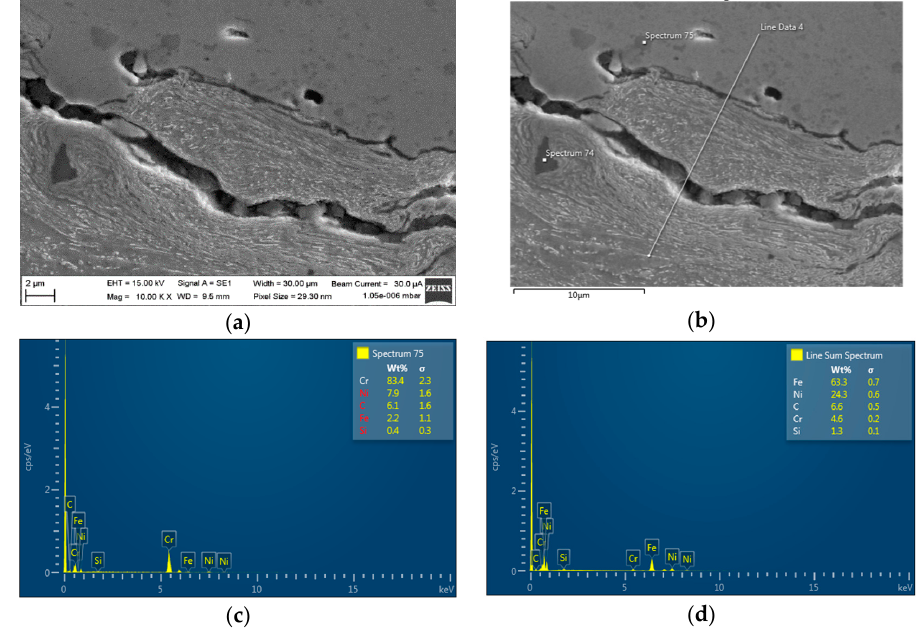
Figure 1. Morphology of NiCrBSi powder: ( a , b ) NiCrBSi powder spraying obtained by scanning electron microscopy; ( c , d ) EDX analysis of NiCrBSi powder. electron microscopy; ( c , d ) EDX analysis of NiCrBSi